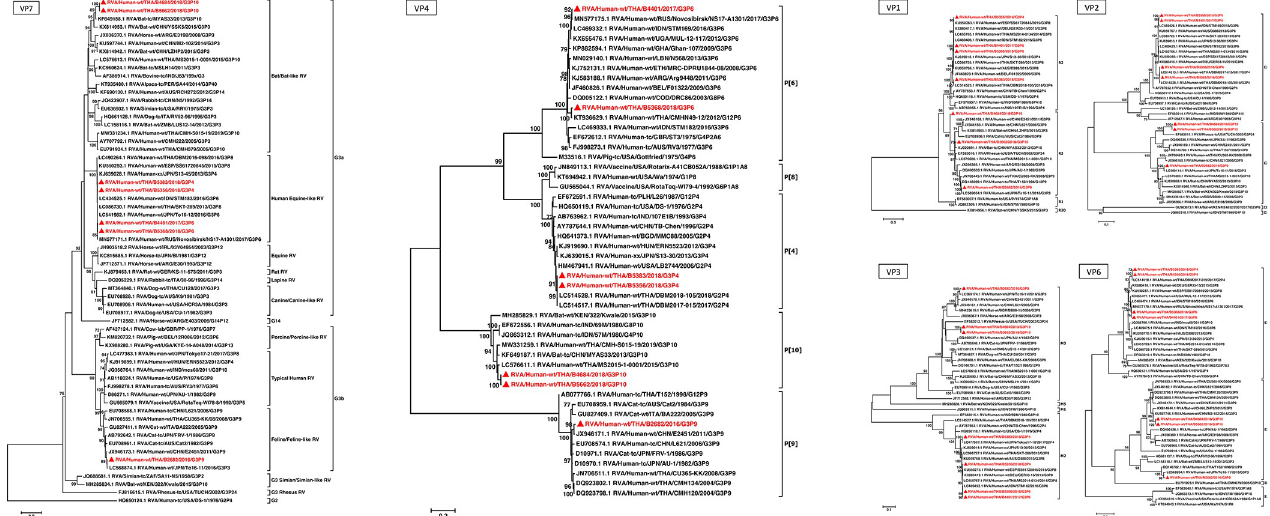
Fig 1. Phylogenetic analysis of the nucleotide sequences of G3 RVA structural protein genes. Thai strains (noted with triangles and in red) were compared to the reference and previously reported RVA strains. Nucleotide sequence lengths used in the maximum-likelihood phylogenetic analysis for VP1, VP2, VP3, VP4, VP6, and VP7 genes were 3204, 2528, 2507, 759, 1157, and 801 base pairs, respectively. Bootstrap values > 70% are indicated at the tree nodes. Scale bars represent substitutions per nucleotide.